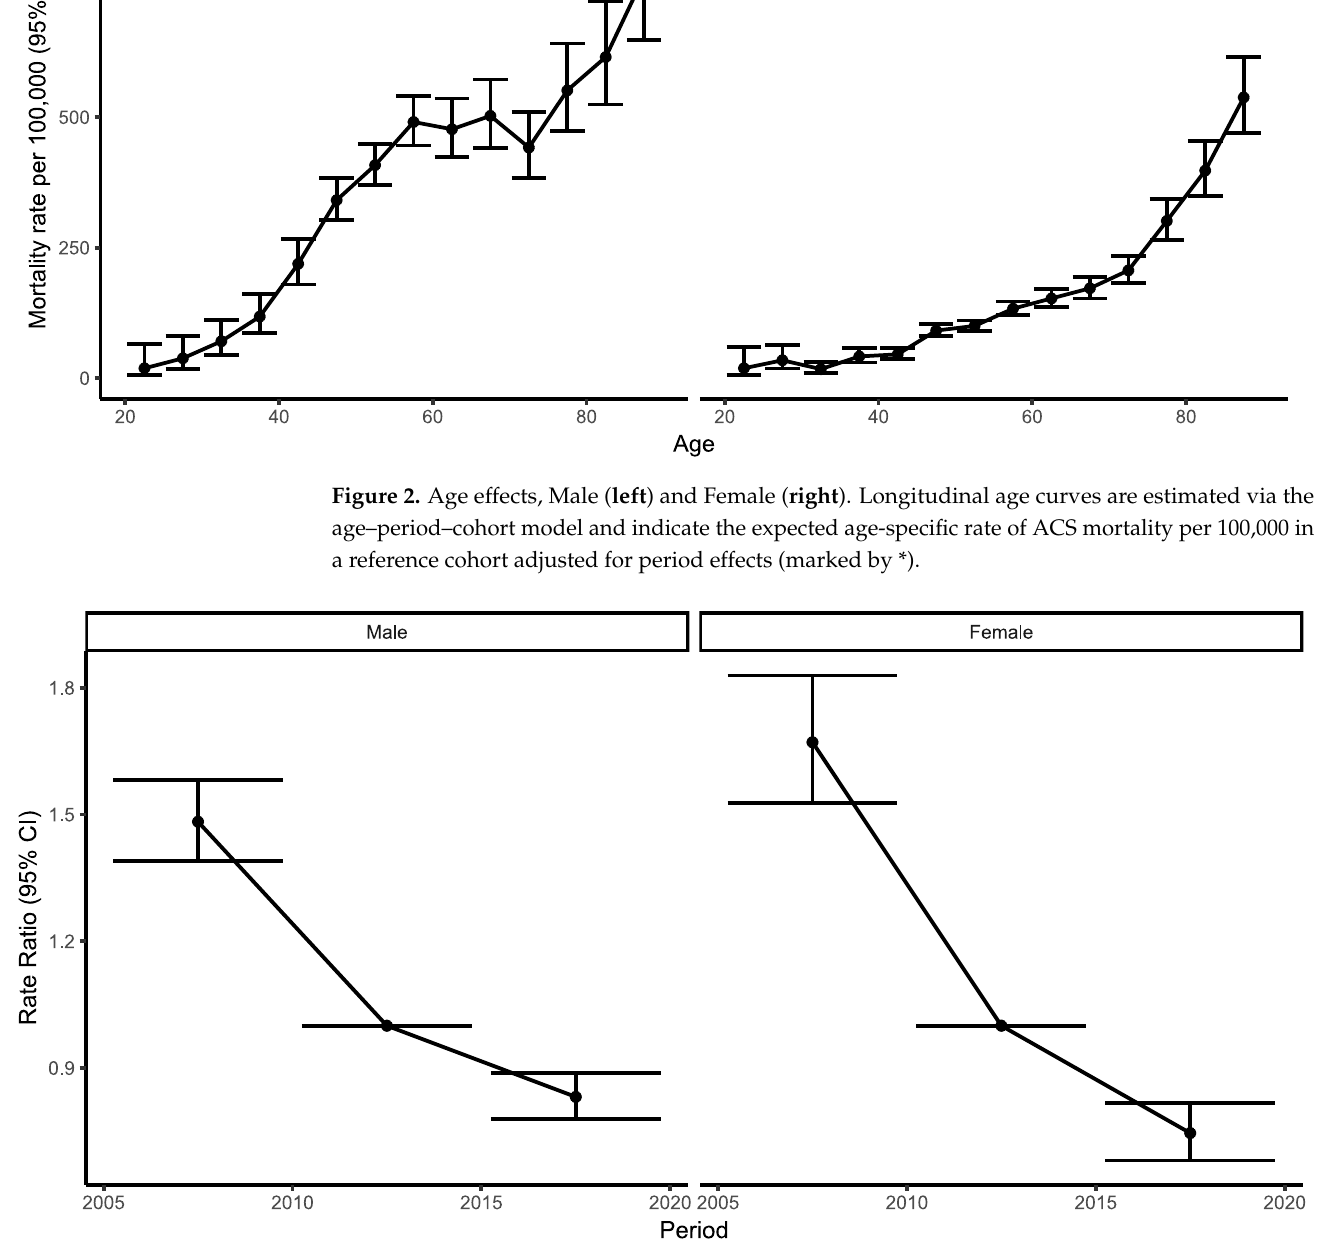
Figure 3. Period effects, Male ( left ) and Female ( right ). Relative risk of each period compared with the reference period—ratio of age-specific rates in each period relative to the reference period.